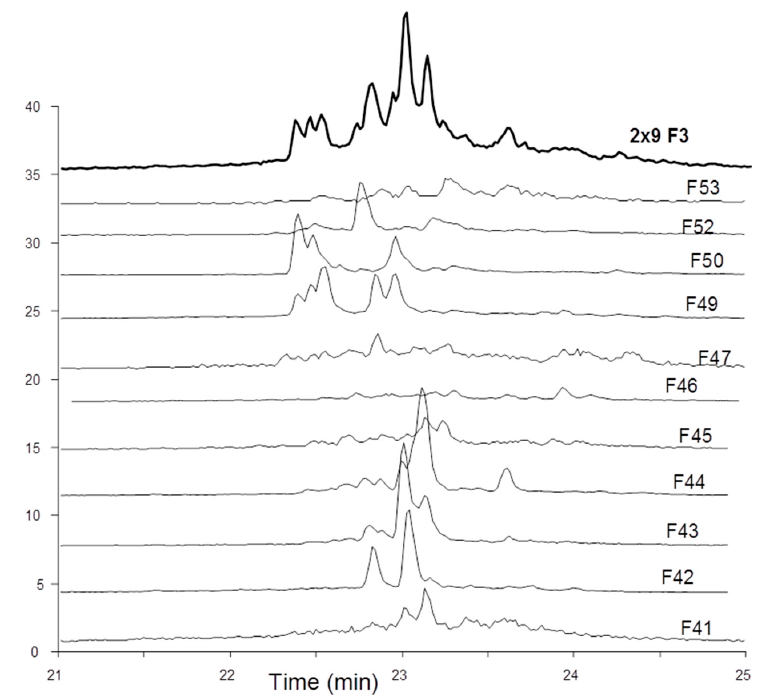
Figure 4. LC/MS reconstructed ion mass chromatograms of initial fraction F3 and sub fractions of interest corresponding to MW 4957 Da ( m / z 2430.2: (4957 + 23 × HXA + 2H) 3+ ).